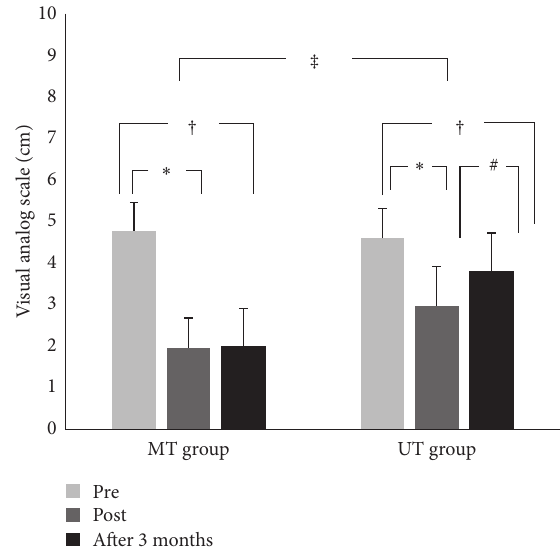
Figure 3: Change of VAS score after training. ∗ Significant dif- ference between pre and post ( p < 0 . 05). # Significant difference between post and after 3 months ( p < 0 . 05). † Significant difference between pre and after 3 months ( p < 0 . 05). ‡ Significant difference between MT and UT group ( p < 0 . 05).